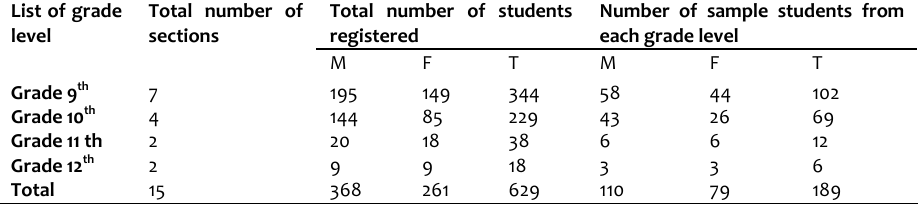
Table 1: Sample of students’ included in the study from each grade